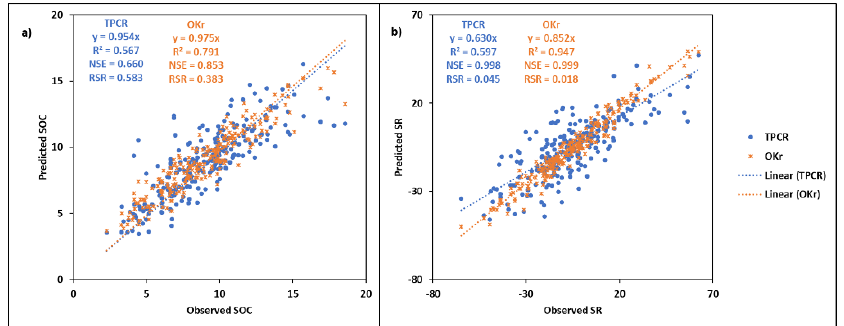
Figure 3. Comparison of topographic principal component regression (TPCR, blue data points) and ordinary kriging (OKr, orange data points)-derived ( a ) soil organic carbon (SOC) density (kg m − 2 ) and ( b ) soil redistribution (SR) rate (Mg ha − 1 year − 1 ) estimations for observations at field site 1.